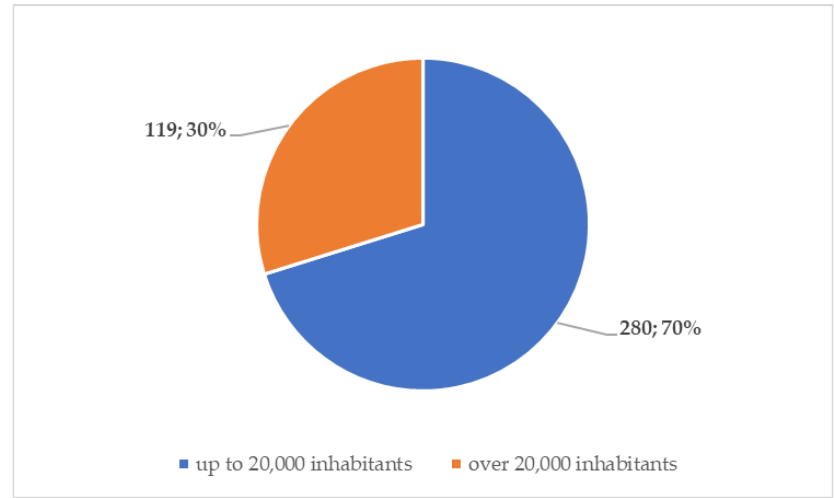
Figure 1. Structure of the surveyed cities by population.